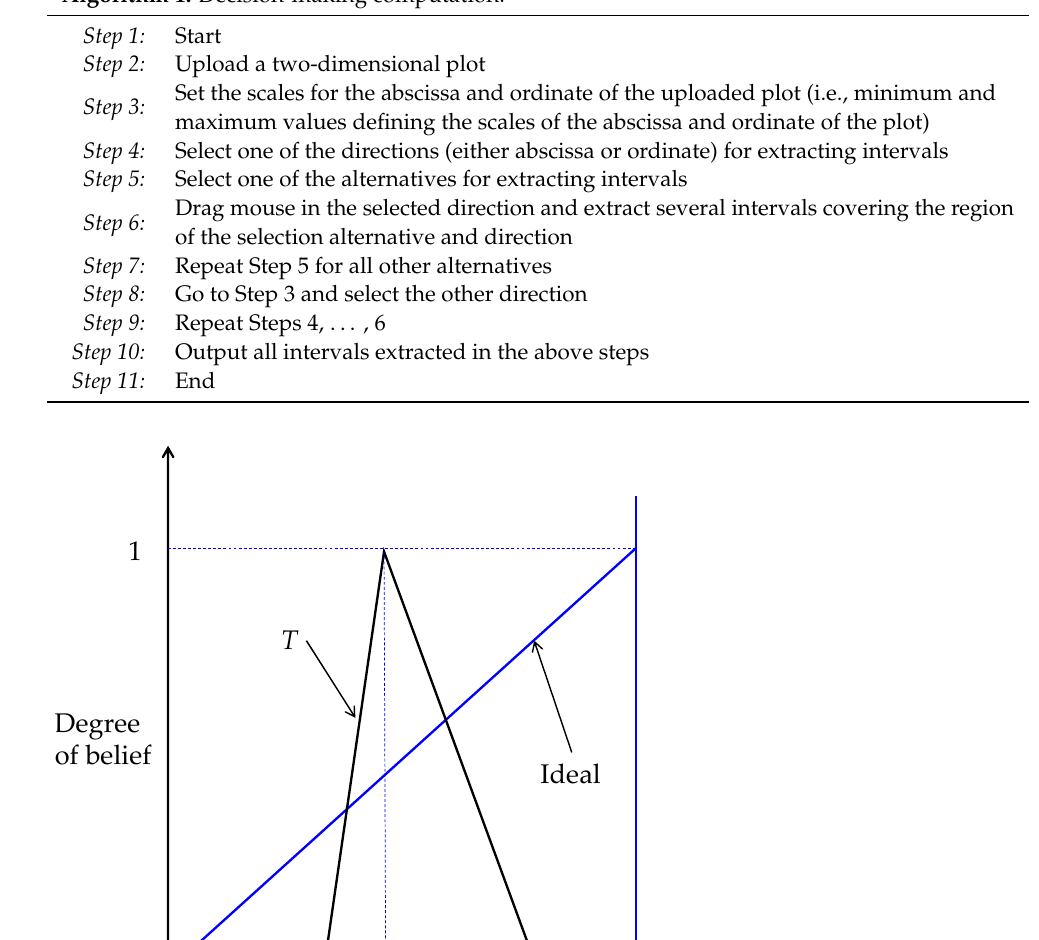
Algorithm 1: Decision-making computation.